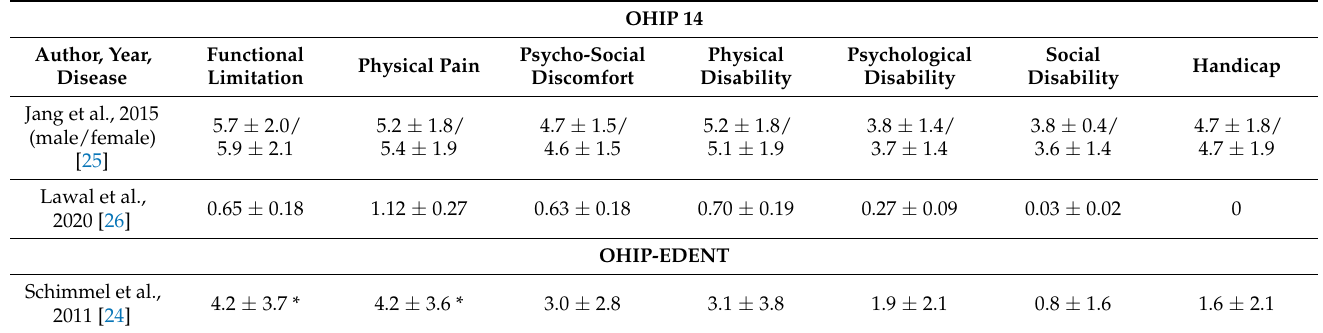
Table 5. Subscales of OHRQoL in the included studies, if applicable. The results are given as the mean values ± standard deviation or otherwise as